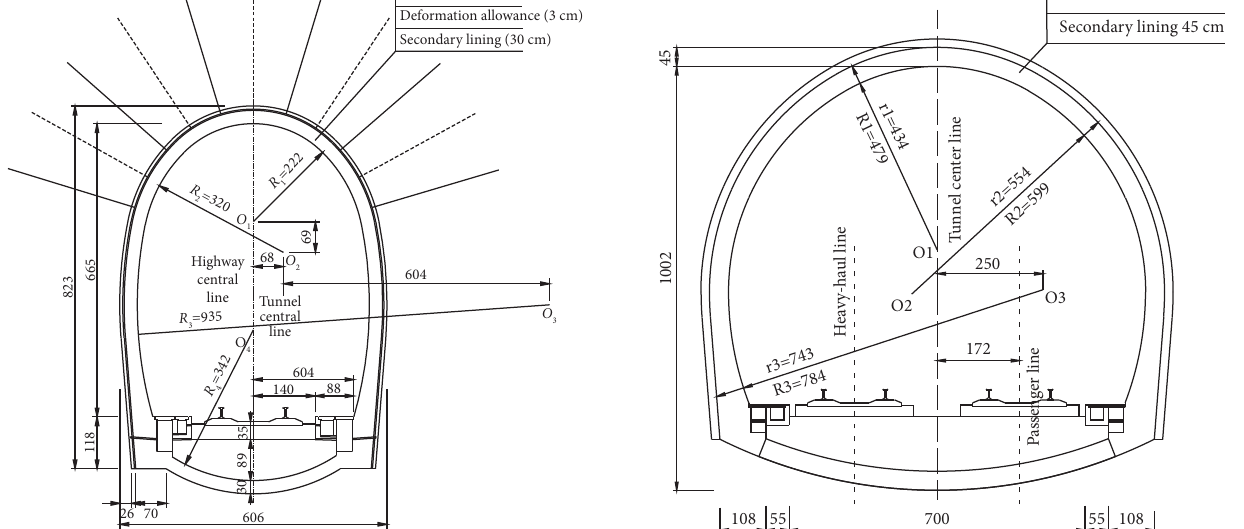
3: Cross section of design lining of double-track heavy-haul railway tunnel (unit: